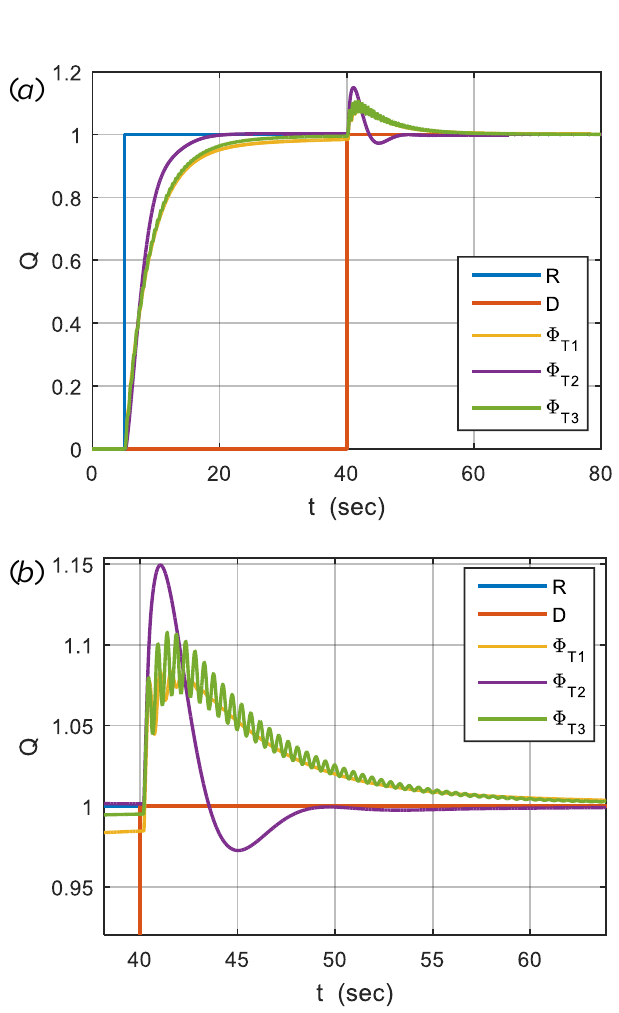
Figure 13. Step disturbance responses of FOPID controller designs for the target angle specifications φ T 1 , φ T 2 and φ T 3 ; ( a ) a full view from simulation and ( b ) a close view of disturbance sponses.